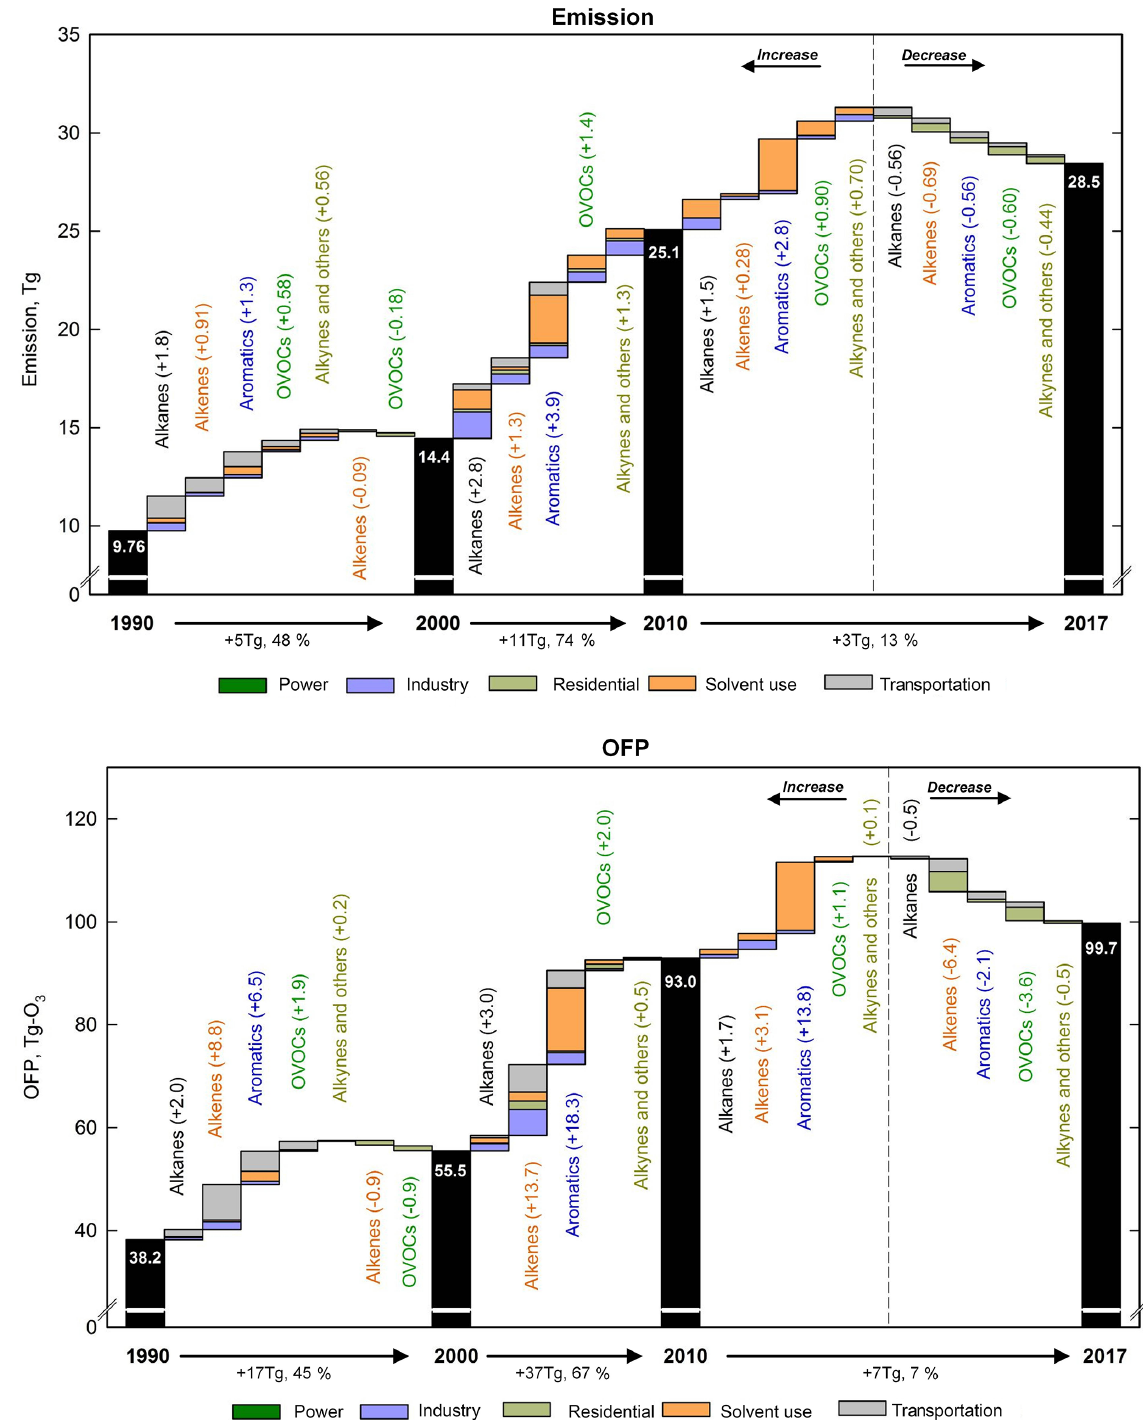
Figure 5. Decomposed changes by chemical group and sector for emission and OFP from 1990 to 2017. Each bar represents the contribution by chemical group to the total emission or OFP changes for the specific time